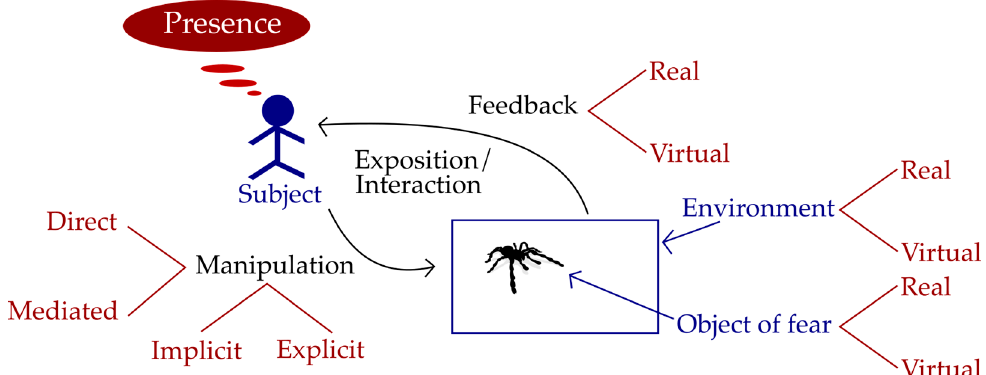
Figure 2. Interaction cycle (Manipulation – Feedback) between the subject, the environment and the object of fear in the exposure therapy